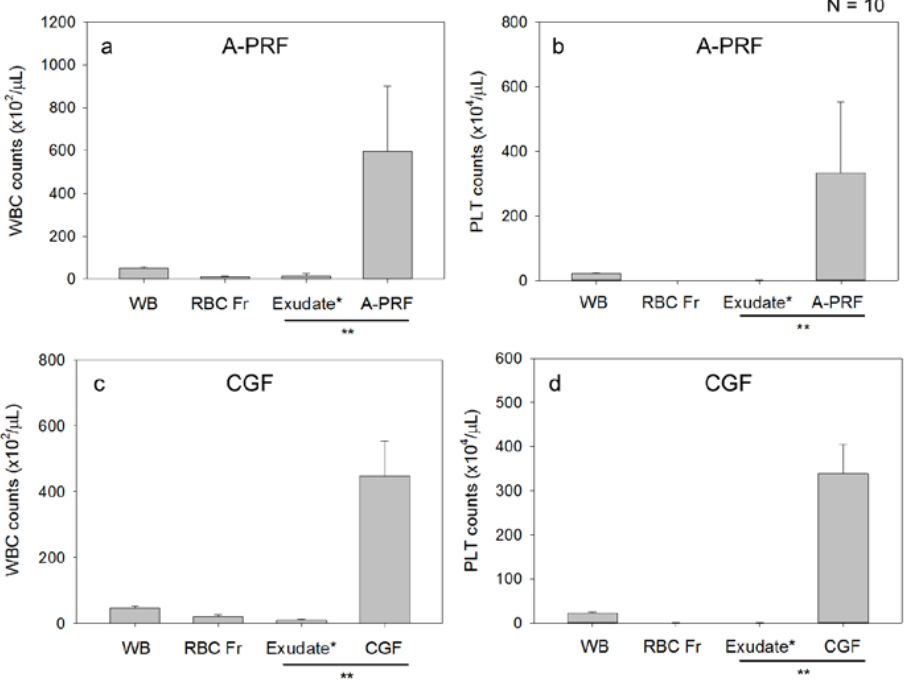
Figure 3. WBC ( a , c ) and platelet (PLT) counts ( b , d ) in the A-PRF ( a , b ) and CGF preparations ( c , d ). Peripheral blood samples were collected into glass tubes in the absence of the anti-coagulant and centrifuged by the individual centrifugation protocols. The freshly formed fibrin clots were withdrawn and dissected from the RBC clots. The resulting A-PRF/CGF preparations were compressed to collect the exudate fractions, whereas the RBC clots were minced and gently combined with the liquid form of RBC fraction. WBC and platelet counts were determined in the whole samples, A-PRF/CGF exudate fraction, and RBC fractions. Calculated WBC and platelet counts in the A-PRF/CGF preparations, which were calculated by the subtraction method, were substantially greater than that of the other fractions. N = 10. * The exudate fraction also included a small volume of the acellular serum fraction. ** Sum of these fractions corresponds to the upper plasma fraction shown in Table 1.